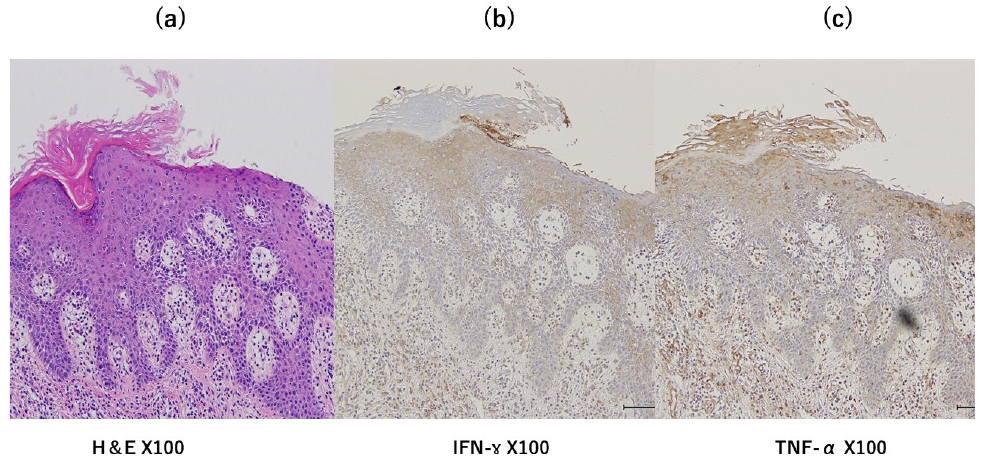
Figure 2. ( a ): The hematoxylin and eosin (HE) stain showed acanthotic proliferations as the irritated- type feature (scattered keratinocyte apoptosis and dyskeratosis, spongiosis, scale crust, and parakeratosis in the stratum corneum) of SK. ( b ): The INF- ɤ stained strongly in the epidermis and stained on mononuclear inflammatory cells for attacking SK. ( c ): TNF- α was stained weekly in epidermis and inflammatory cells compared with INF- ɤ .